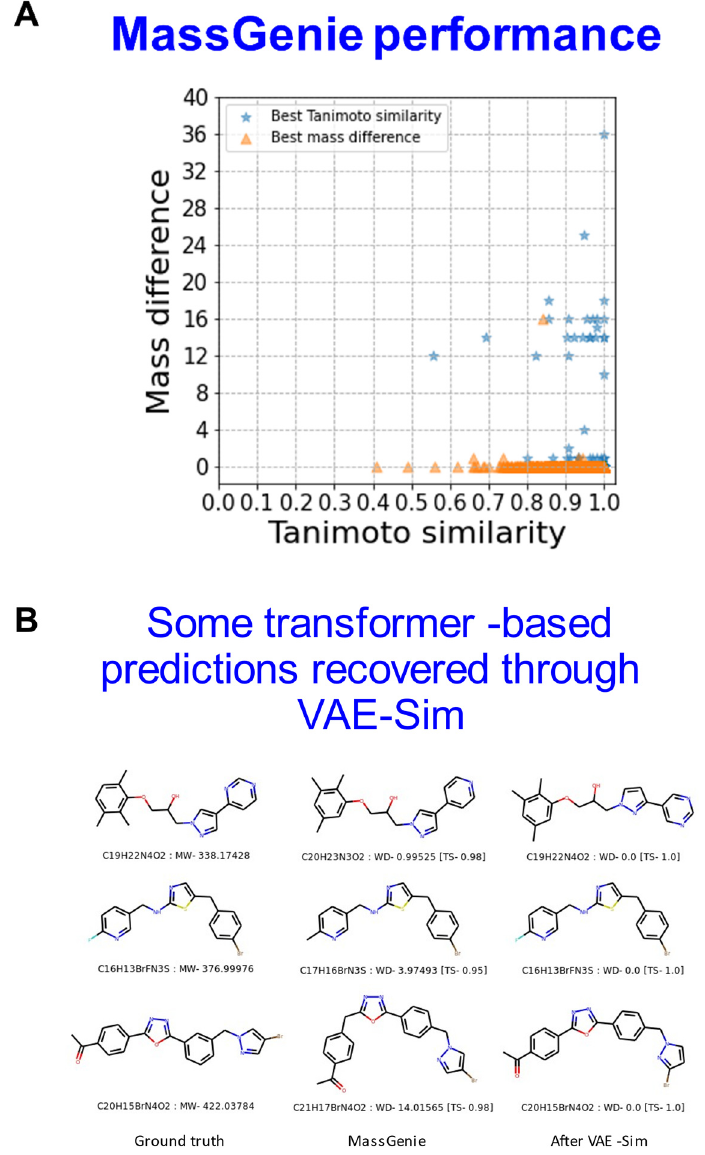
Figure 5. Local search where mass predictions are inaccurate. ( A ). All examples from Figure 3 in which the transformer predicted molecules with slightly incorrect masses. VAE-Sim was used to search locally and generate further candidate structures that were round-tripped using FragGenie to produce mass spectra that could again be ranked in terms of TS to the known, true molecule given either the optimal mass difference or the optimal TS. ( B ). Three examples showing the ground truth, the transformer’s best estimate, and the best (and accurate) prediction after the candidate pool of molecules was enhanced using VAE-Sim.